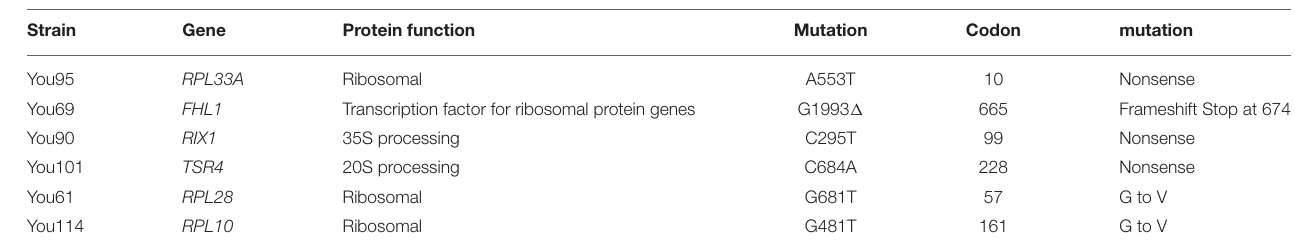
TABLE 1 | List of strains and mutations isolated in the selection for AT-resistance. Strain